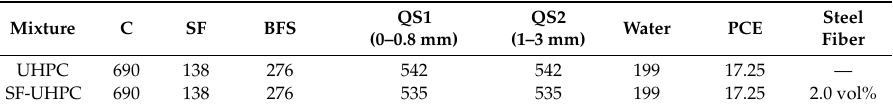
Table 1. Mixture proportions per unit weight (kg / m 3 ).